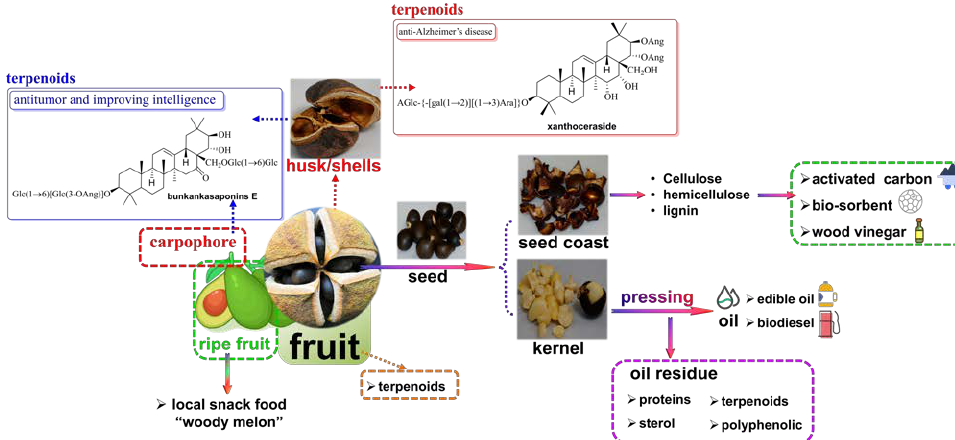
Figure 3. The uses of the fruit of X.